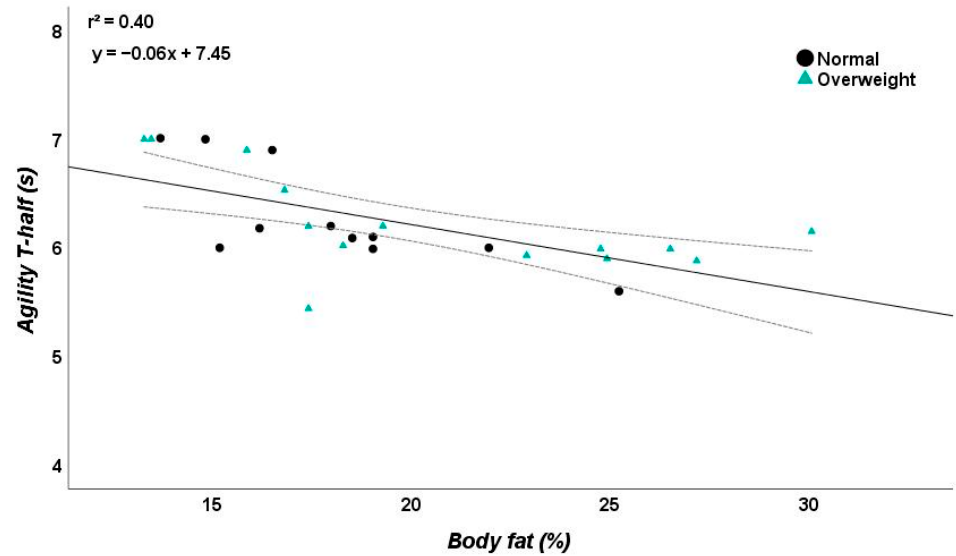
Figure 1. Relationship between body fat and agility depending on the group. Please note that one dot can represent several subjects. Table 3. Summary of the linear regression analyses for the anthropometric variables predicting the performance parameters. Body height and body mass were entered as predictors in step 1, while the percentage of body fat (%) was added in step 2. Nonstandardized regression coefficients ( β ) are given for each predictor. r 2 > 0.5 marked in bold. SJ: squat jump,